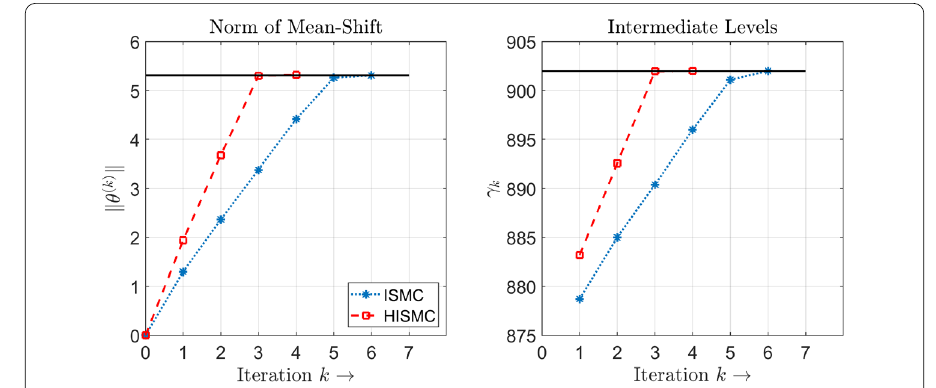
Figure 5 Memory cell: the mean-shifts θ ( k ) and intermediate levels γ k at iteration k